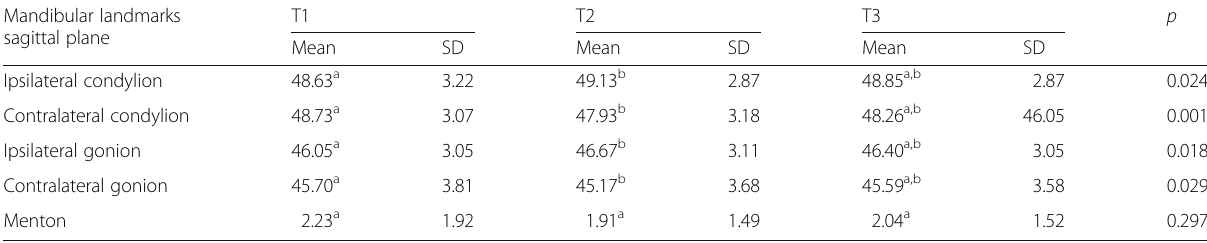
Table 3 Mean and standard deviation of distances (millimeter) between the mandibular landmarks and the sagittal plane observed at the three time-point evaluations. Results for repeated measures ANOVA Mandibular landmarks sagittal plane